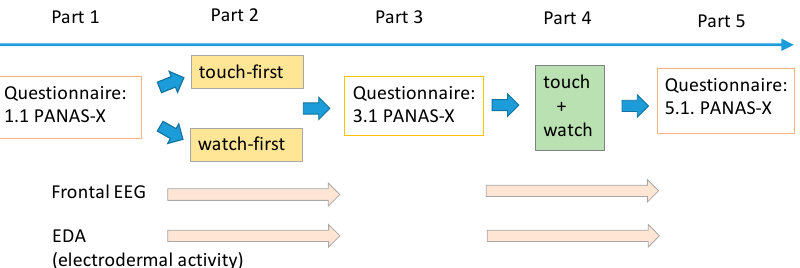
Figure 2. A schematic illustration of the experimental design. The experiment consisted of 5 parts. In Part 1, all participants answered a questionnaire (PANAS-X). In Part 2, participants were assigned randomly to the touch-first or watch-first condition (unimodal condition). In Part 3, all participants answered PANAS-X to indicate their emotions. In Part 4, all participants touched and watched the plant for 1 min (multimodal condition). Animated images were shown on the flat screen as they touch and watch the plant. In Part 5, Participants indicated their emotional experience with PANAS-X. During Part 2 and Part 4, participants’ brain activity (EEG) and skin conductance (electrodermal activity) were